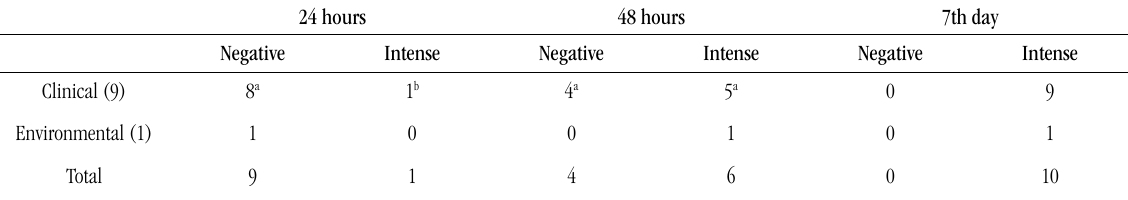
tABLE 11 – Protease production activity in clinical and environmental Cryptococcus gattii samples isolated in Sergipe,